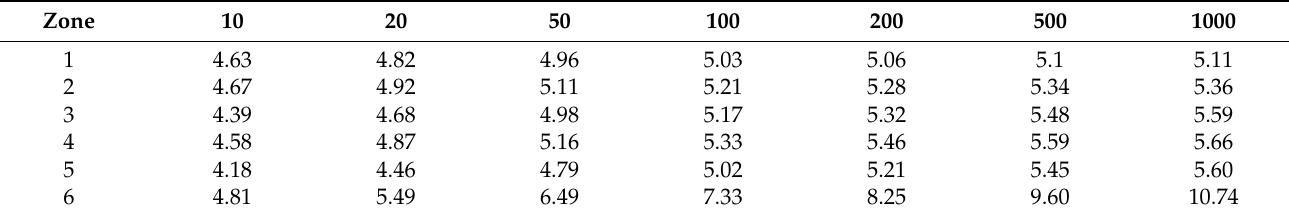
Table 14. The earthquake magnitude return level in Cluster Type II.